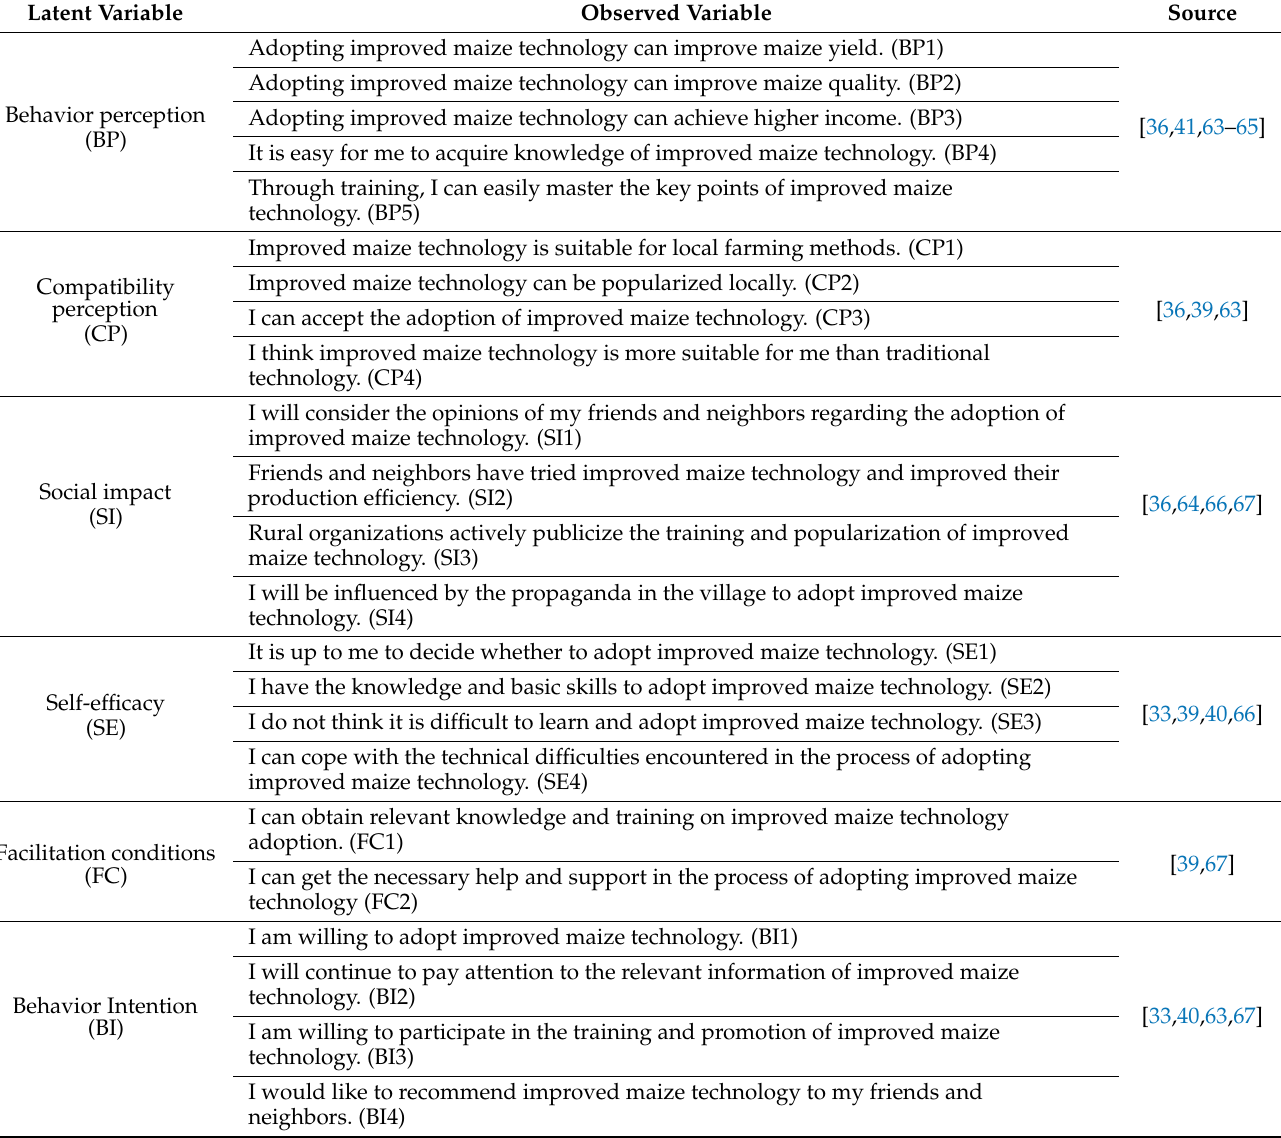
Table 1. Latent variables, observed variables, and source of observed